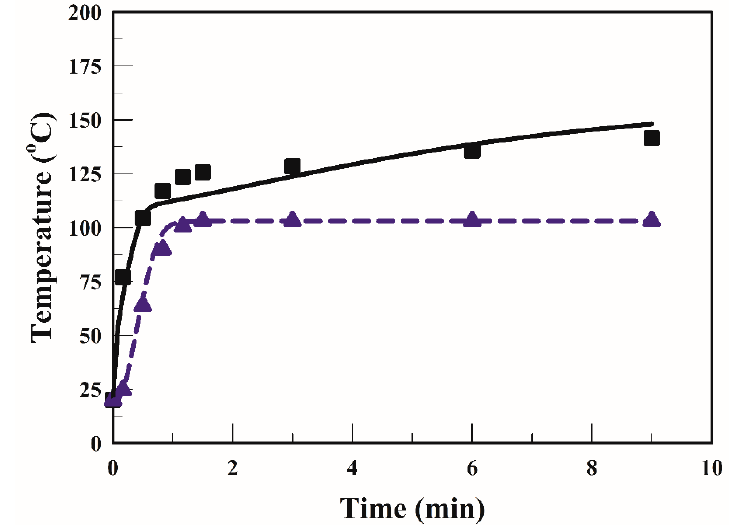
Figure 3. Temperature of the strip at surface ( ■ ) and at core ( ▲ ) with frying temperature of 170 °C. The symbols ■ and ▲ represent the experimental data obtained [20]; the curves represent the simulated values: surface (solid line) and core (dotted line). Table 1. Input parameter values.